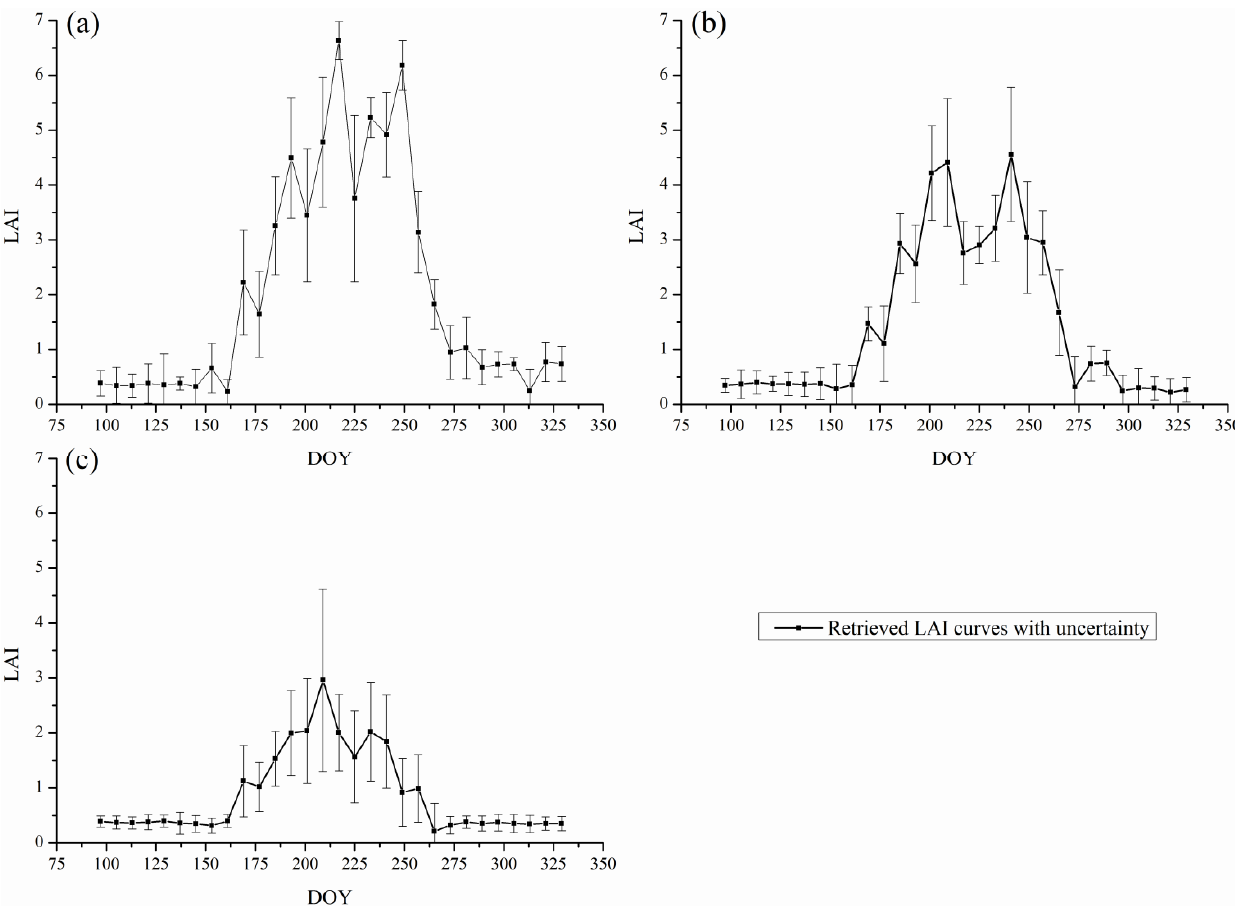
Figure 6. LAI r versus day of year (DOY) for three pixels. The solid line is the LAI r , and the error bars on each DOY represent LAI uncertainty . ( a ) and ( b ) are the LAI r of vegetation near Wutumeiren river; ( c ) is the LAI r of vegetation in drought area. The peak LAI r values in the study period decrease from ( a ) to ( b ) to ( c ).